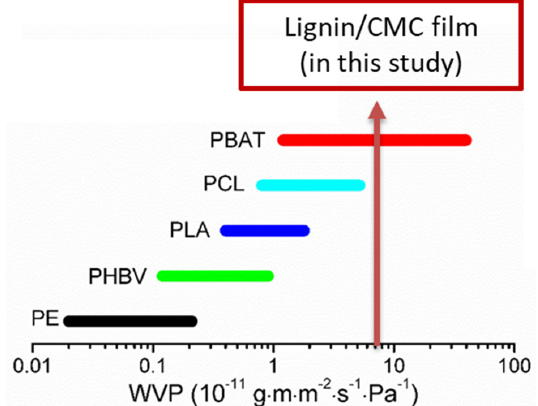
Figure 5. Comparison of WVP values of lignin/CMC film with other biodegradable polymers (PE: polyethylene; PHBV: Poly(3 − hydroxybutyrate − co − 3 − hydroxyvalerate); PLA: polylactic acid; PCL: polycaprolactone; and PBAT: Polybutylene adipate terephthalate) and with PE: polyethylene. Adapted with permission from [49]. Copyright 2018 American Chemical Society.